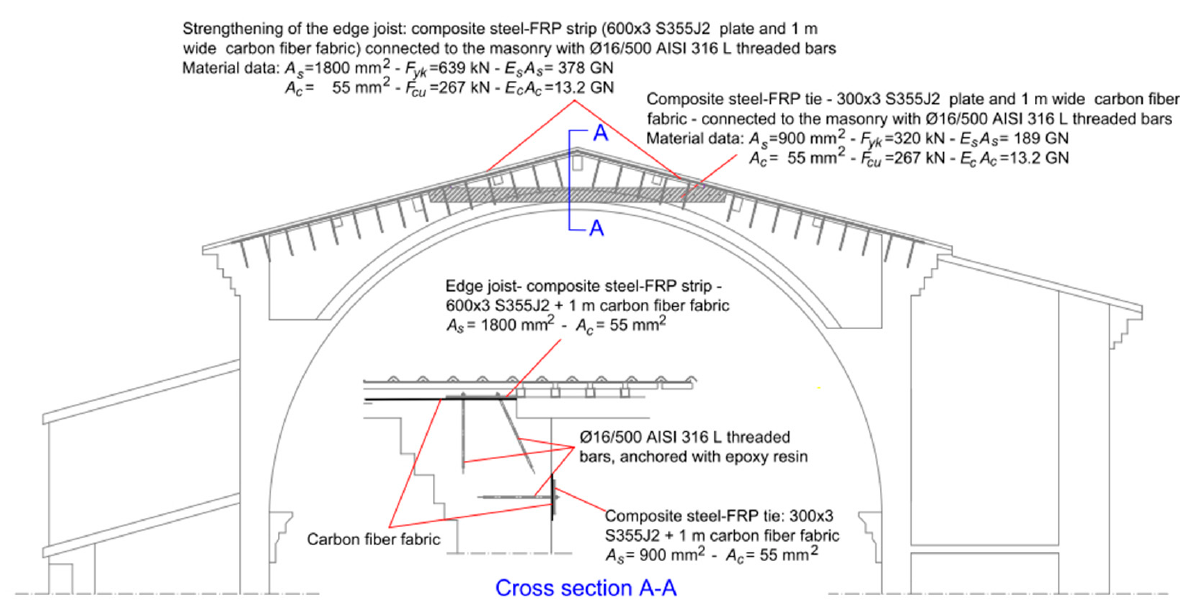
Figure 20. Main façade: strengthening of the edge joist at the top of the gable: type A intervention.